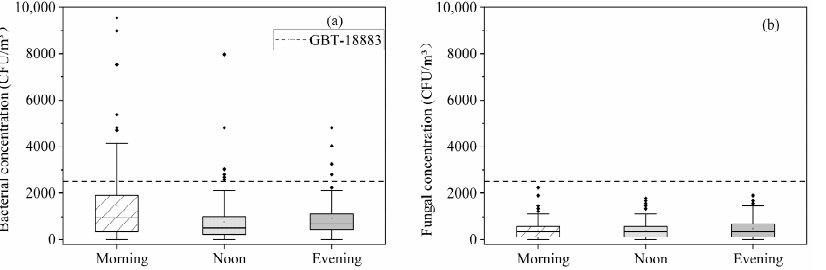
Figure 3. Microbe concentrations in the dormitory in the morning, noon and evening: ( a ) bacteria; ( b ) ( b ) fungi.